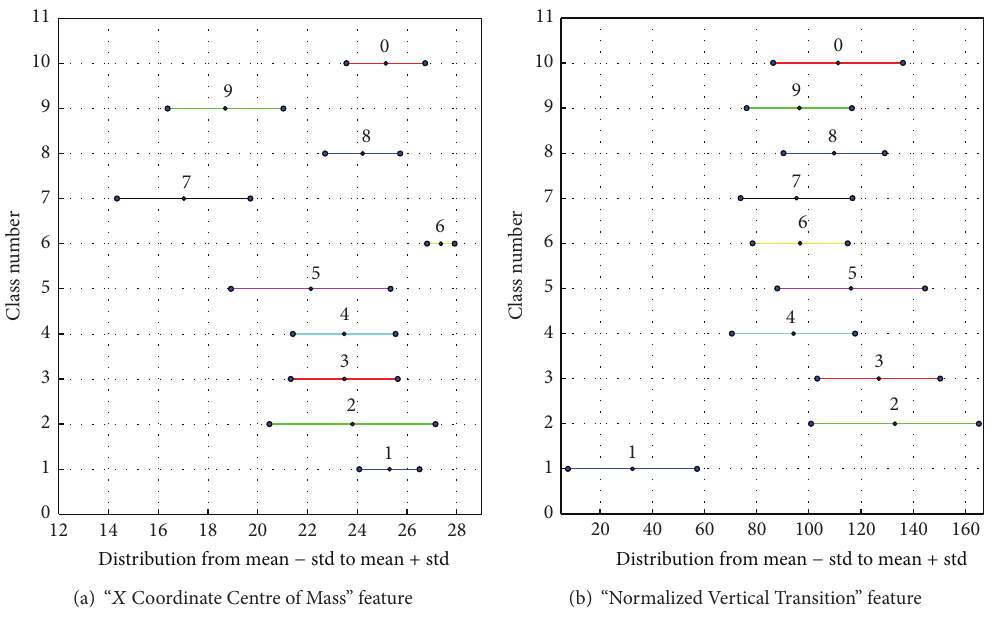
Figure 3: 1D SD spectrum distribution diagrams for the English digits